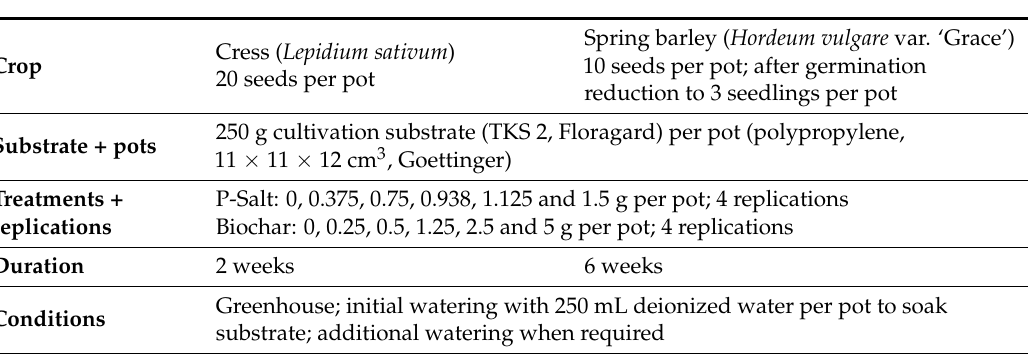
Table 3. Experimental set-up of crop growth